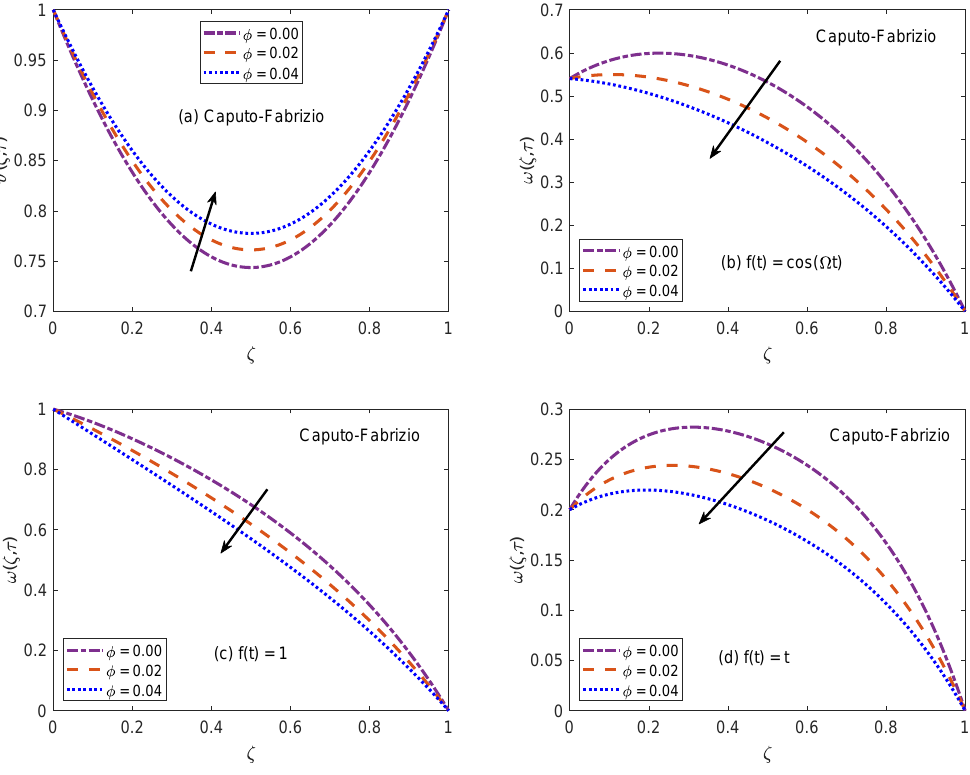
Figure 5. Temperature and velocity patterns of CF model for variation of φ